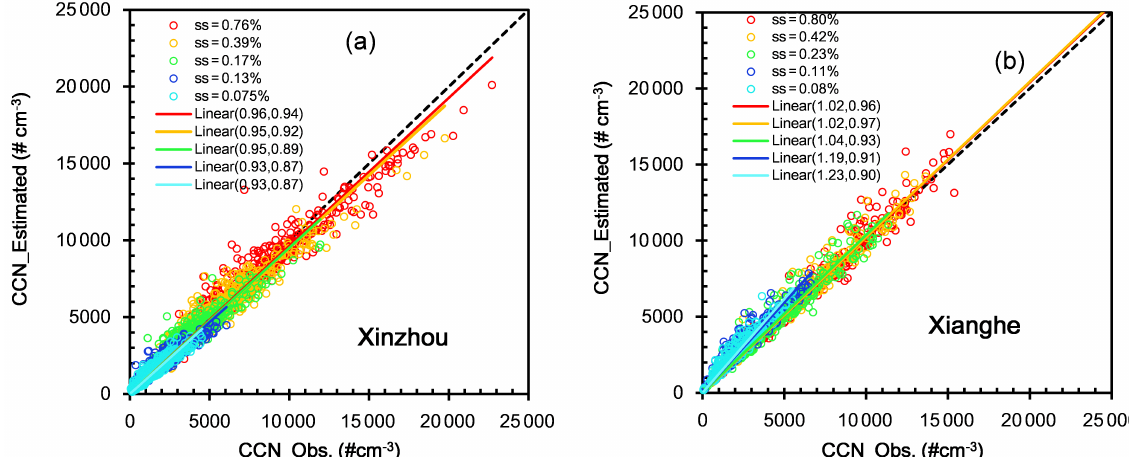
Figure 7. Estimated N CCN as a function of observed N CCN for different supersaturation levels at (a) Xinzhou and (b) Xianghe. Note that the campaign mean CCN efficiency spectra at Xinzhou are used for estimating N CCN at Xianghe. Linear best-fit lines through each group of points are shown. Slopes and R 2 values are given in